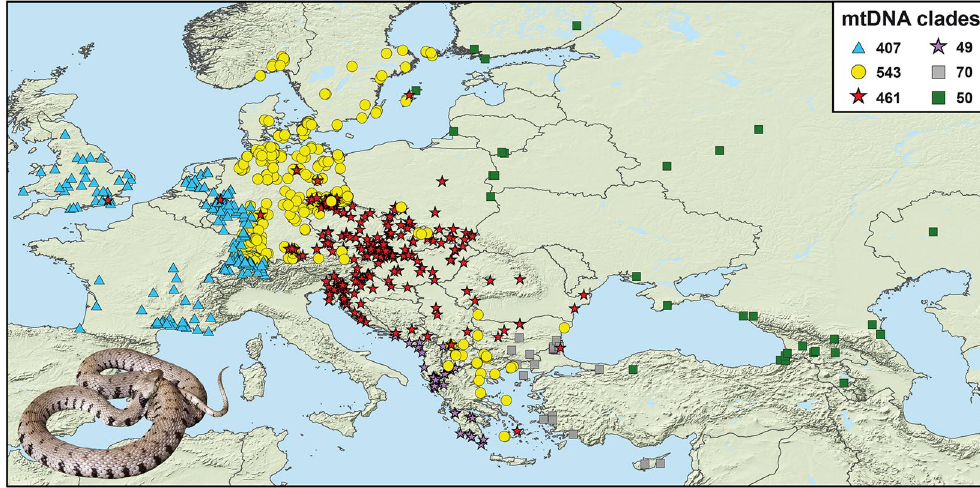
Figure 1. Distribution of mitochondrial lineages of 1,580 grass snakes used in this study. Total sample size of each clade shown in the legend. Eight allochthonous grass snakes with haplotypes of Italian lineages caught in southern Great Britain and Hesse, Germany, not shown. Map was created using arcgis 10.2 (http://www.esri. com/arcgis) and adobe illustrator CS6 (http://www.adobe.com/products/illustrator.html). Inset: Natrix natrix helvetica (Linz am Rhein, Germany); photo: Wolfgang